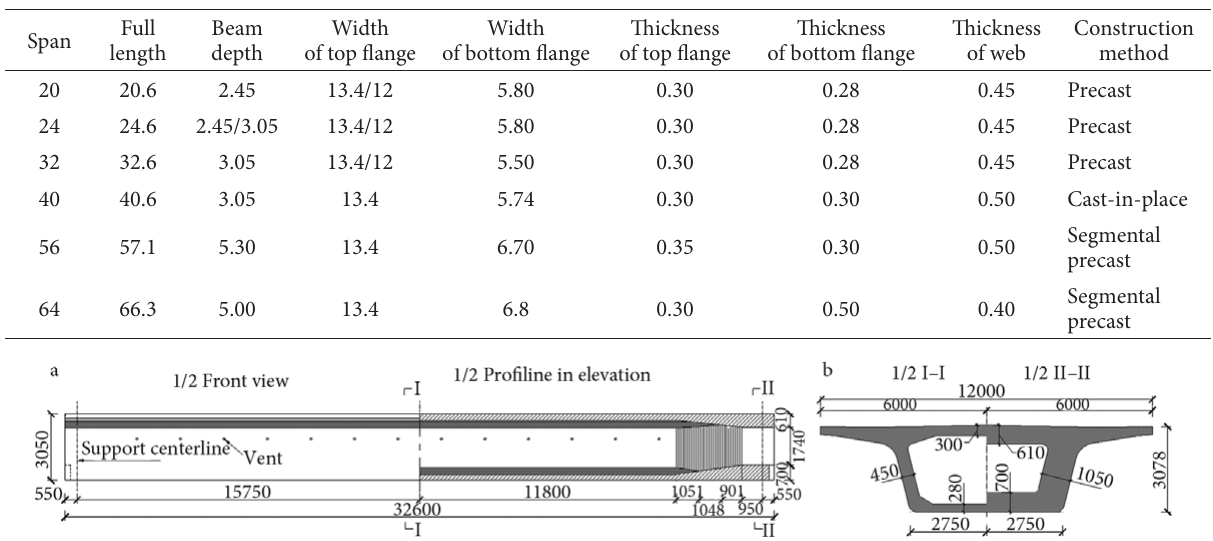
Fig. 2. 32 m standard simple beam, in mm: a – elevation view; b –